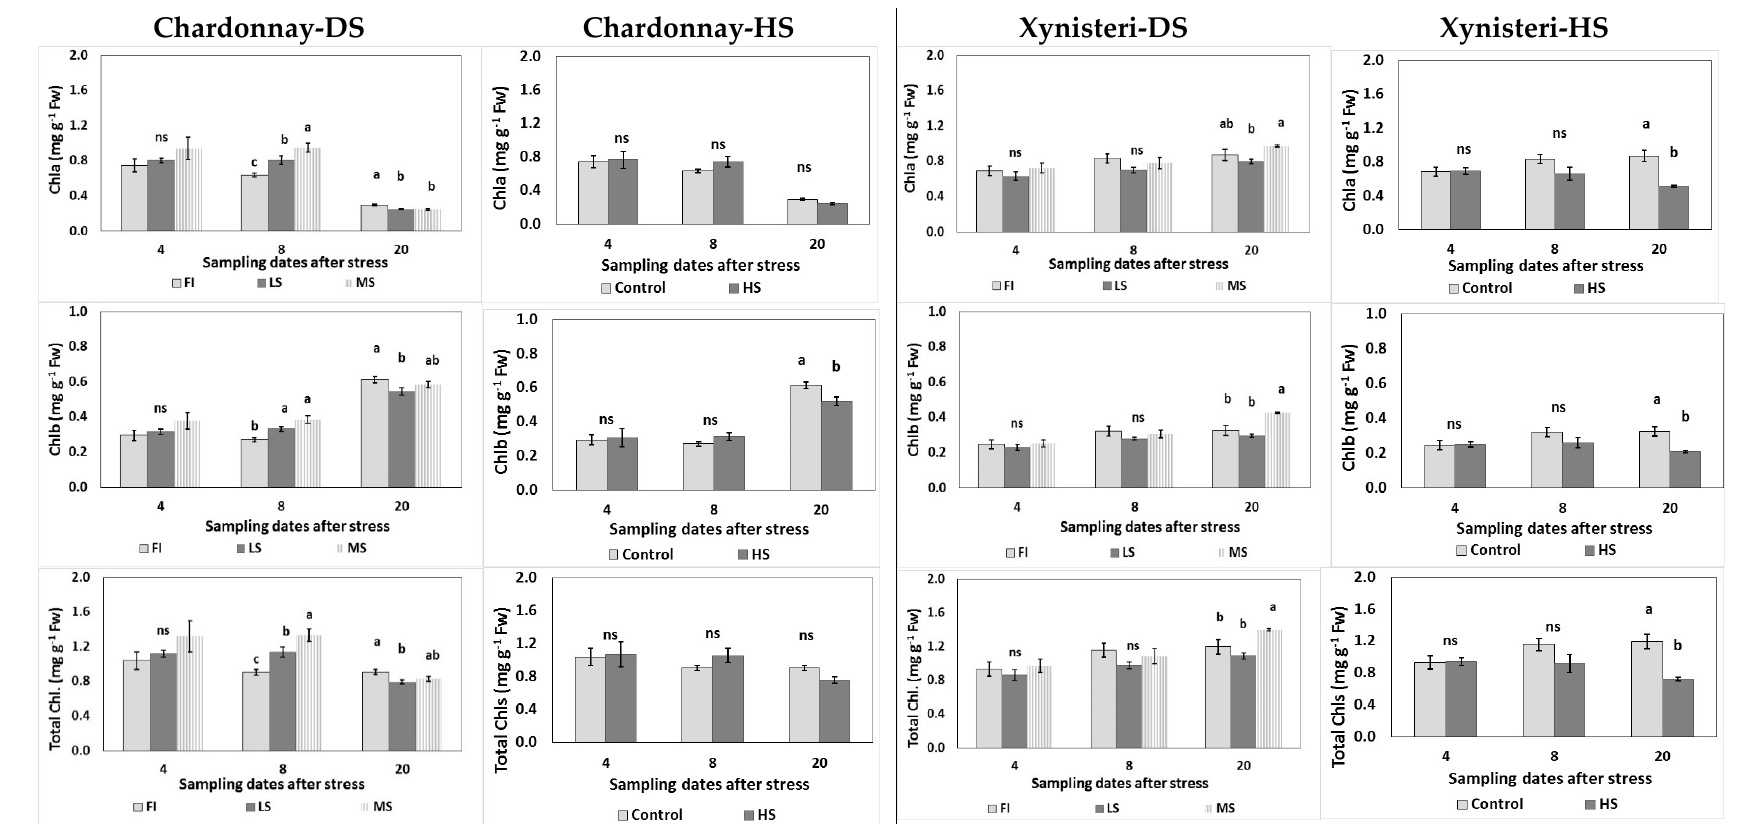
Figure 3. Impact of short-term drought and heat stress on chlorophyll content in Chardonnay and Xynisteri cultivars. Plants were full irrigated (FI) or exposed to light water stress (LS) with 80% of the FI, moderate water stress (MS) with 50% of the FI, and heat stress (HS). Chlorophyll a (Chl a), chlorophyll b (Chl b), and total chlorophyll (total Chl) were determined after 4, 8, and 20 d of stress. Data are means ± SE ( n = 4), and significant differences ( P < 0.05) among treatments are indicated by different letters (a, b, c, ab). ns: not significant.